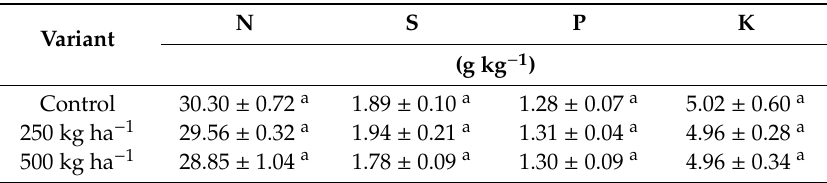
Table 3. N, S, K, and P contents in black locust leaves on research